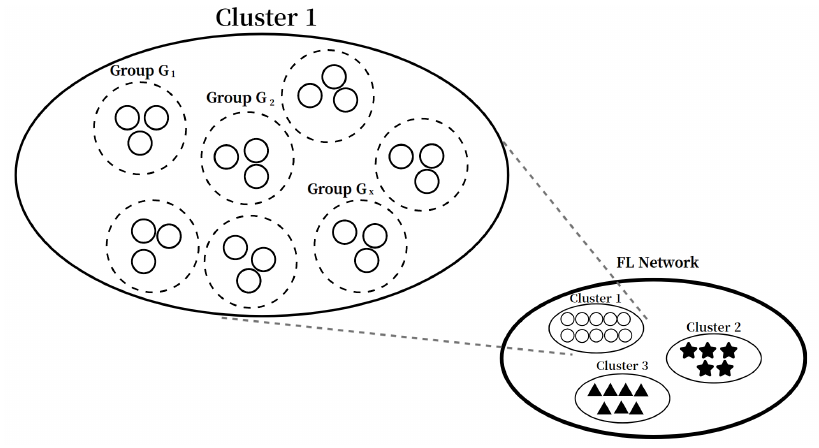
Figure 7. Example of the grouping clients in clusters when | s t | =